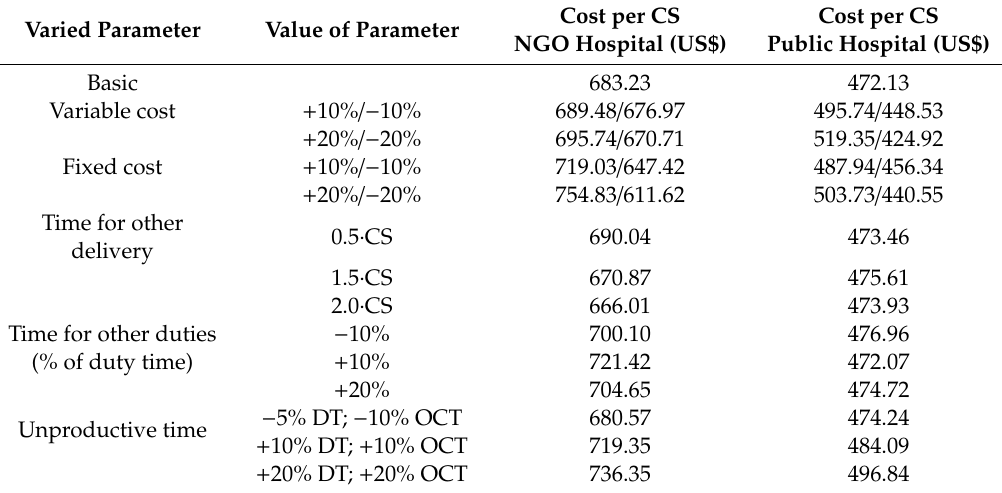
Table 9. Sensitivity